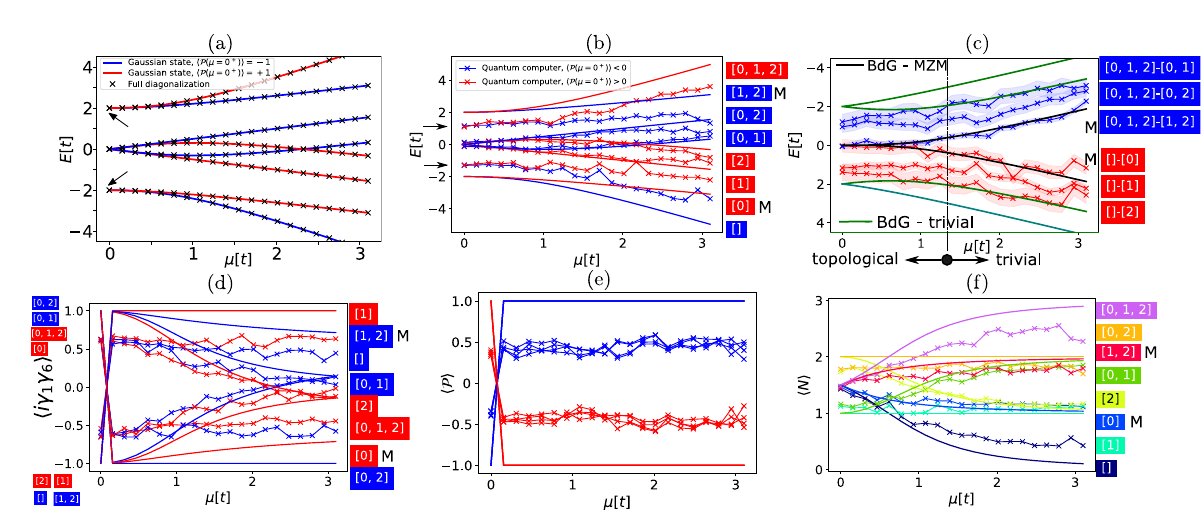
Figure 2. Quantities of the Kitaev Hamiltonian at t = − 1 and (cid:31) = 1 as a function of the chemical potential µ in units of absolute value of tunnelling [ t ]. ( a – e ) Black “x” symbols represent a result of a numerical diagonalization on a classical computer. Red “x” symbols (full lines) values obtained on a quantum computer (ideal simulator of quantum computers) with � P (µ = 0 + ) � = 1 . Blue “x” symbols (full lines) values